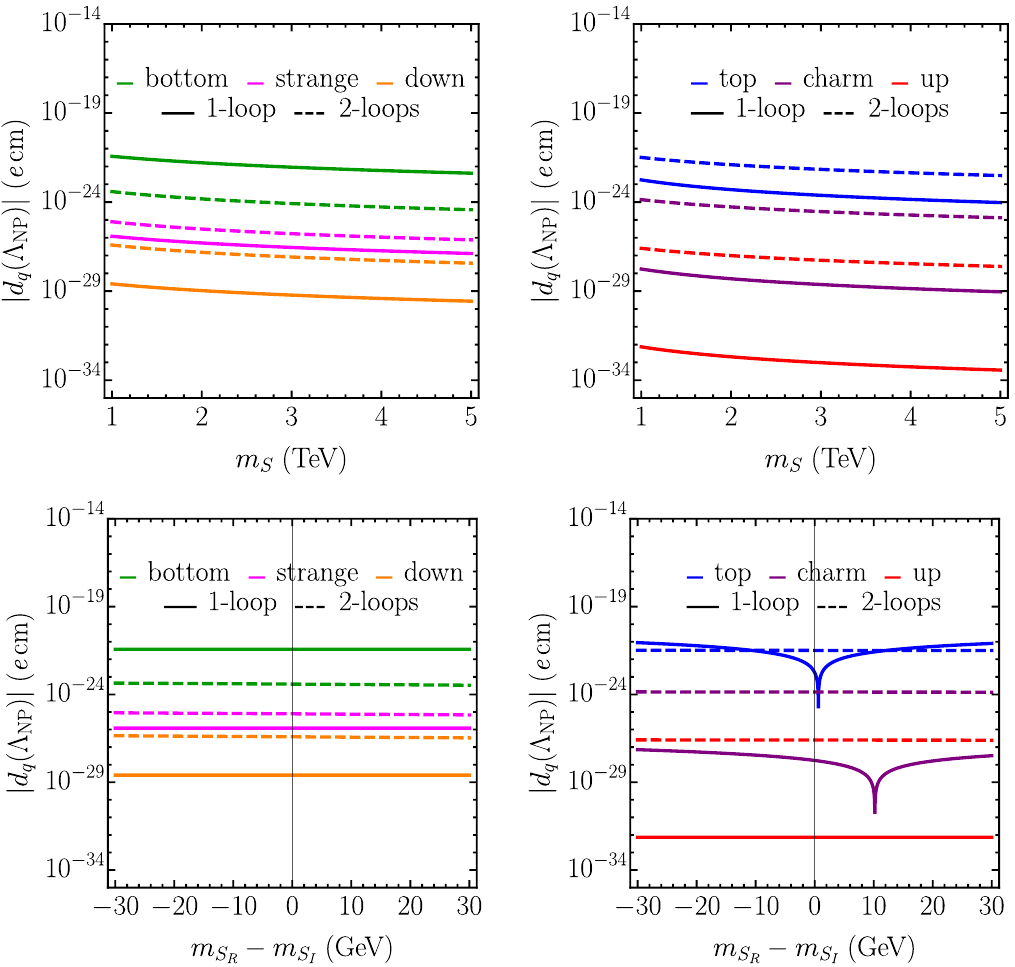
Figure 8 . Comparison of the 1- and 2-loop contributions to the EDM of the up-type quarks (left) and down-type quarks (right), as a function of the mass of the scalars m S (top) and the mass splitting of the neutral scalars m S − m S (below). The Yukawa couplings have been fixed to R I | η U | = | η D | = 1 , arg( η U ) = π/ 4 , and arg( η D ) = 0 . The masses have been fixed to m + m S = m S , and m = m S = 1 TeV in the top and bottom panels, S + I I